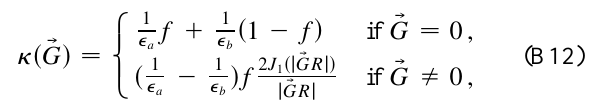
FIG. 11. (Color) Cylinder in a unit